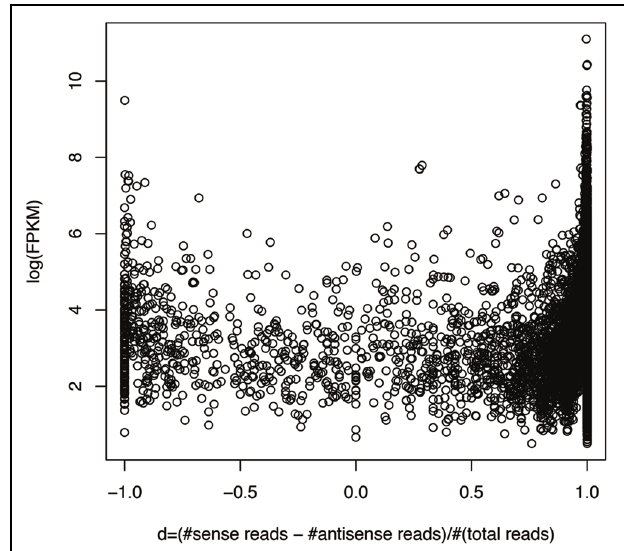
FIGURE 6 | Different Streptococcus species have different levels of antisense transcripts. The y-axis shows the ratio of genes with antisense transcription. The x-axis shows the different species; sang: S. anginosus C1051, sanc: S. anginosus C238, sif: S. infantarius CJ18, smut: S. mutans GS5, smj: S. mutans LJ23, smc: S. mutans NN2025, smu: S. mutans UA159, scp: S. parasanguinis ATCC 15912, scf: S. parasanguinis FW213, stf: S. salivarius 57 I, ssr: S. salivarius CCHSS3, stj: S. salivarius JIM8777, ssa: S. sanguinis SK36, stc: S. thermophilus CNRZ1066, stu: S. thermophilus JIM